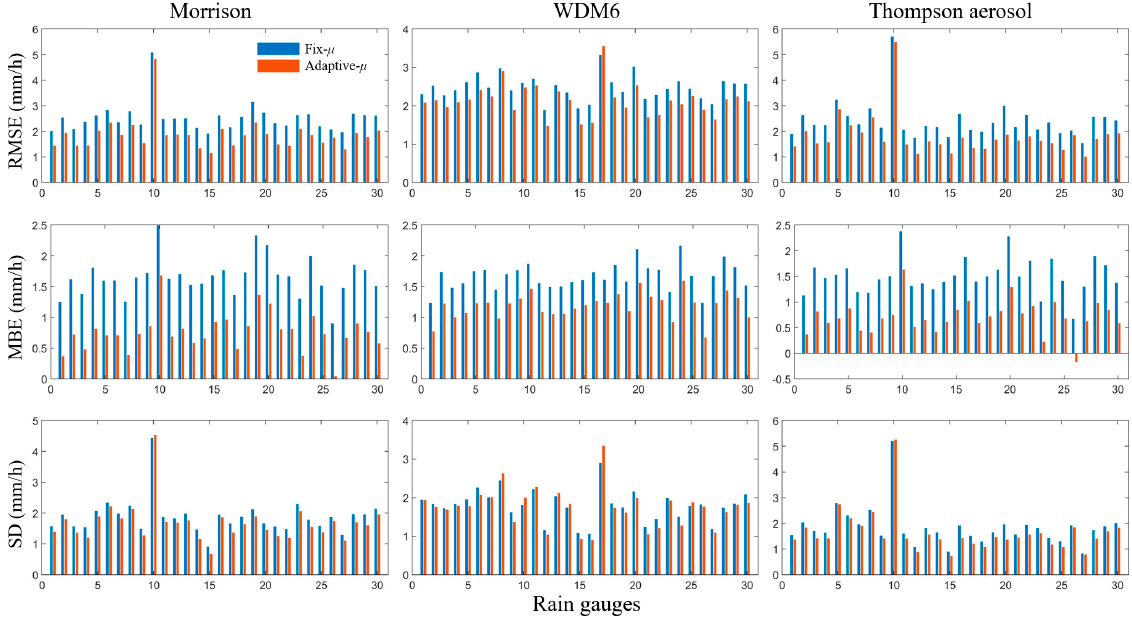
Figure 11. Comparison of the fixed- and adaptive- μ model results in terms of RMSE, MBE, and SD indices for 30 validation points and three double-moment schemes.